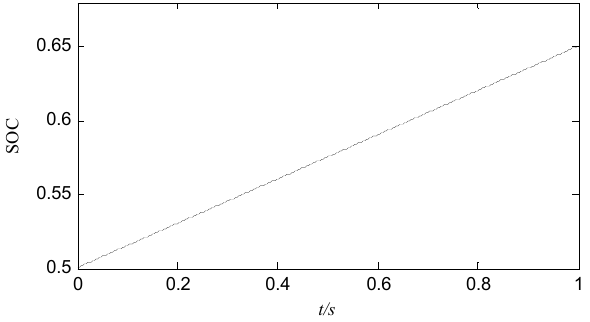
Figure 19. The curve of battery state of charge (SOC).